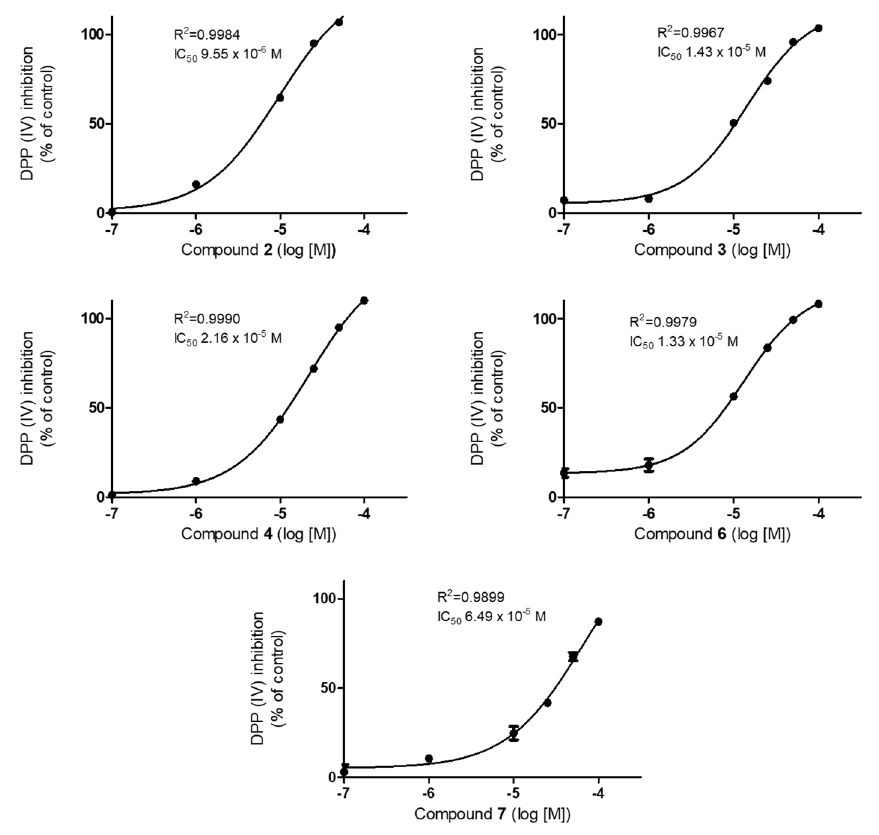
Figure 3. E ff ects of compounds 2 – 4, 6 and 7 on DPP-IV activity. Values are presented as the mean ± SD of three independent experiments.